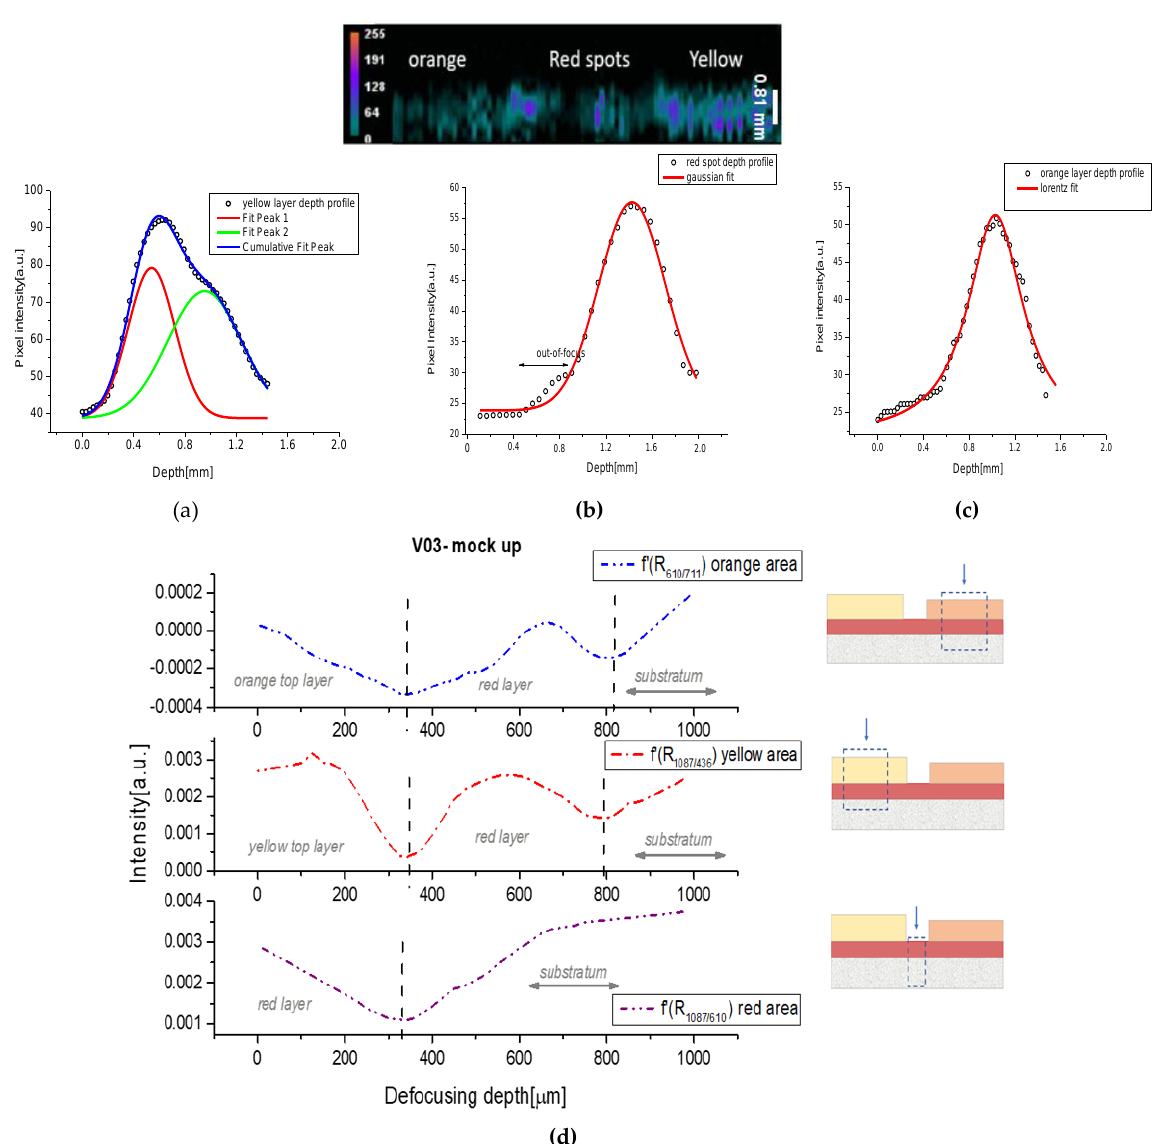
Figure 7. Layers fit of V.03 sample obtained from PA stratigraphic images for: ( a ) the yellow zone; ( b ) the red spots from the bottom layer; ( c ) the orange zone; and ( d ) SORS stratigraphy obtained for the same areas.